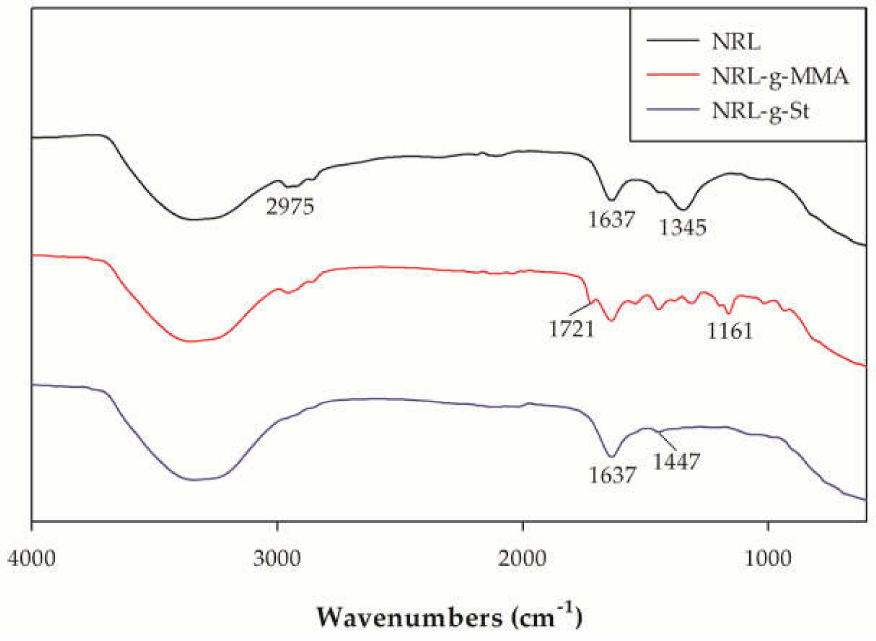
Figure 1. The FT − IR Spectra of NRL, NRL − g − MMA and NRL − g −